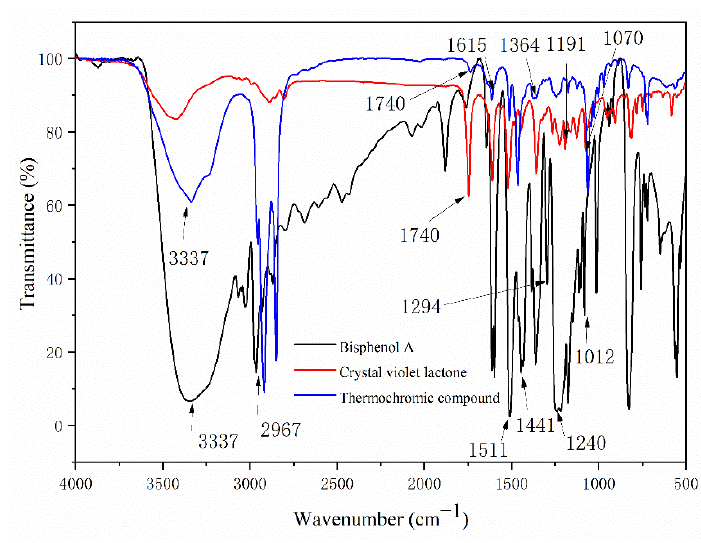
Figure 3. FTIR spectra of BPA, CVL, and the thermochromic compound.